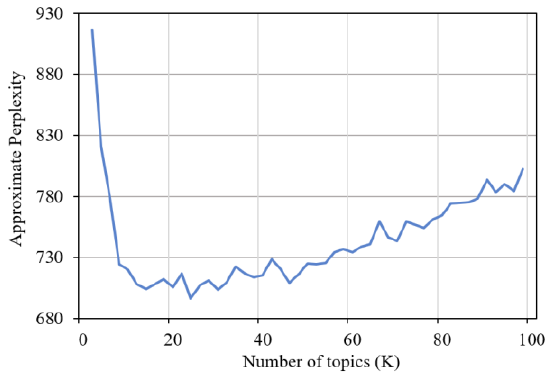
Figure 4. Latent Dirichlet Allocation model perplexity change graph.